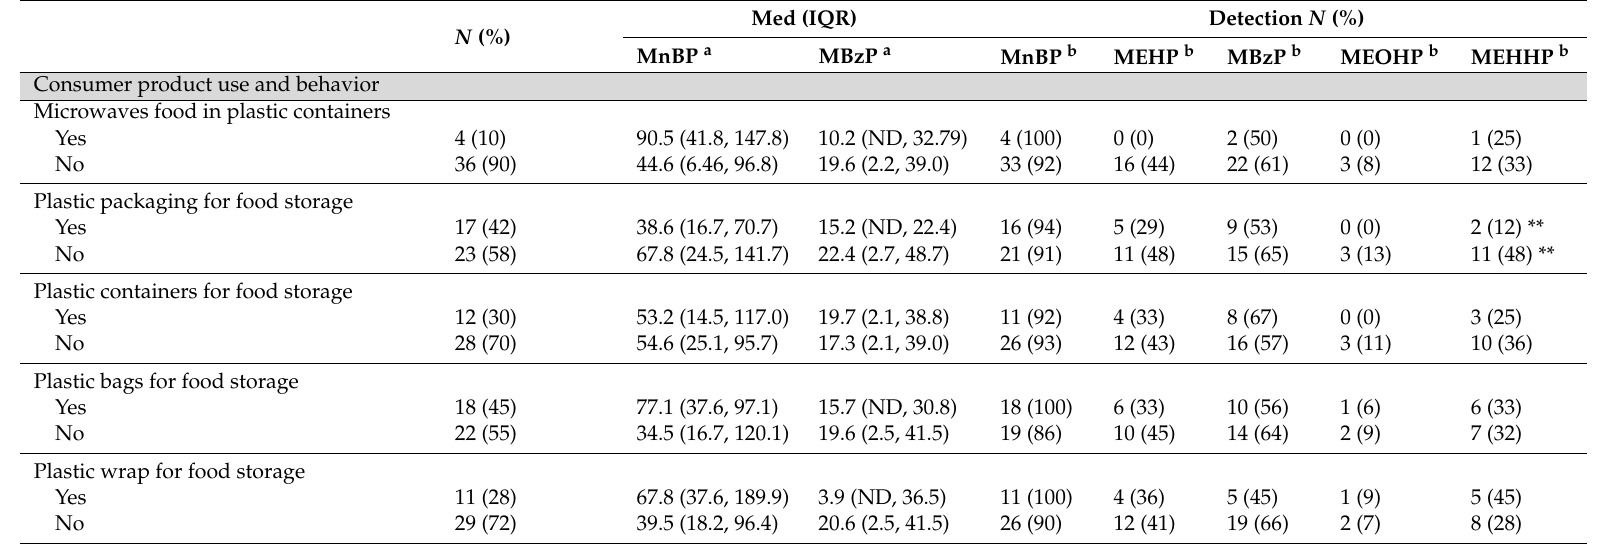
Table 4. Metabolite detection and creatinine-adjusted concentrations ( µ g/g creatinine) by consumer product use and